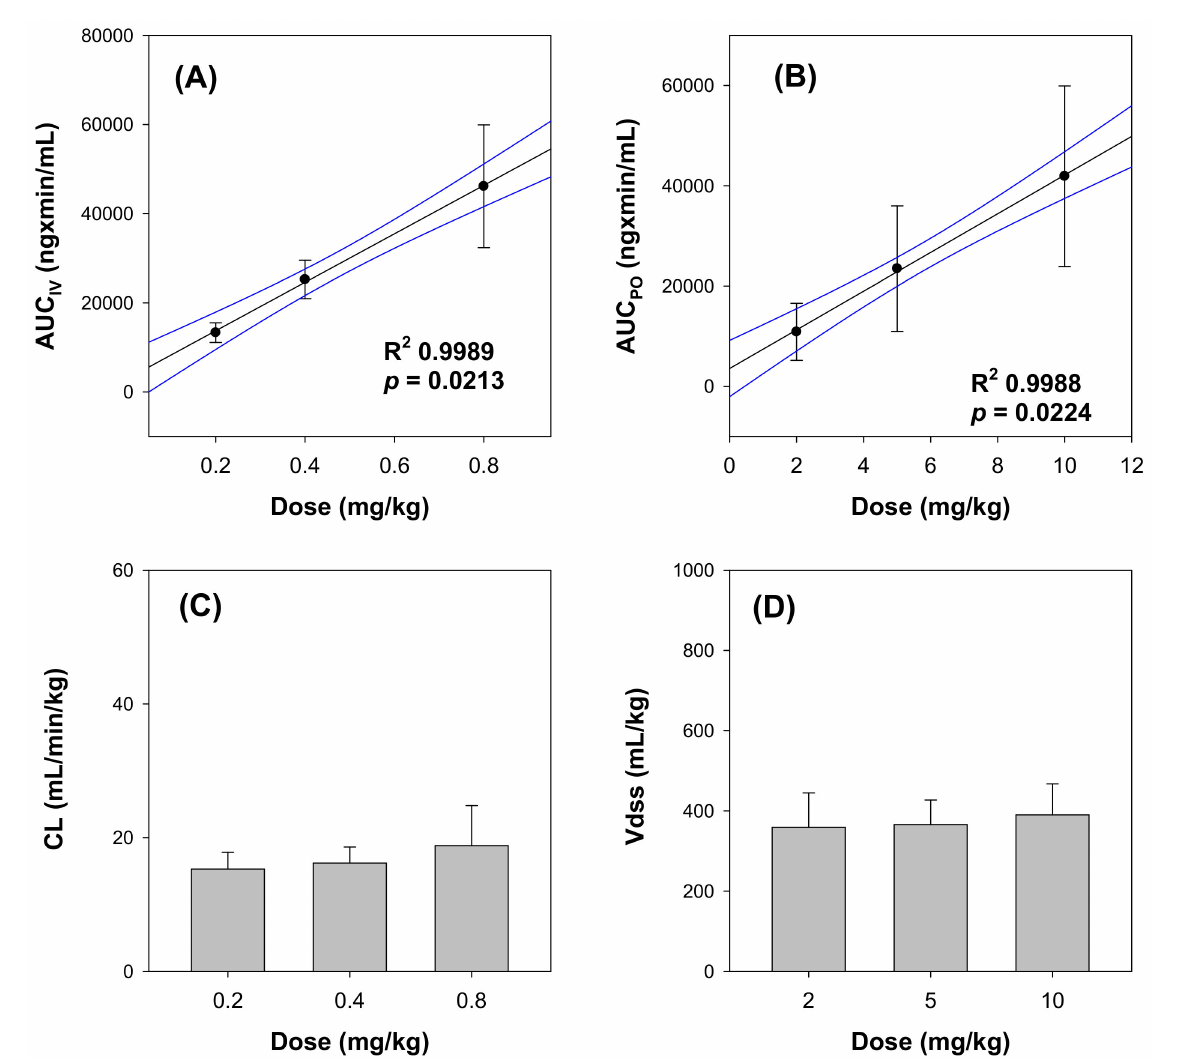
Figure 3. Correlations between AUC IV ( A ) or AUC PO ( B ) values for β -amanitin and intravenous or oral doses of β -amanitin. Lines were generated from linear regression analysis and 90% confidence intervals around the geometric mean value. R 2 represents the correlation coefficient. ( C ) clearance (CL) and ( D ) volume of distribution (V ss ) values of β -amanitin after iv bolus administration of β -amanitin were presented with β -amanitin doses. Each point represents mean ±